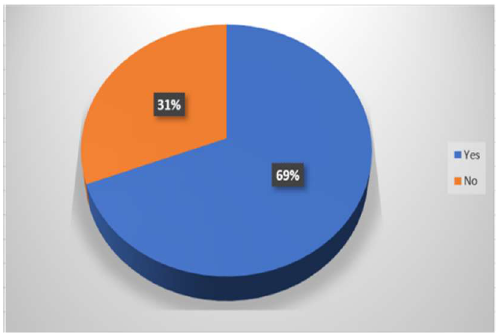
Figure 15. Answers to the first question of Unit A. Resource: own study.